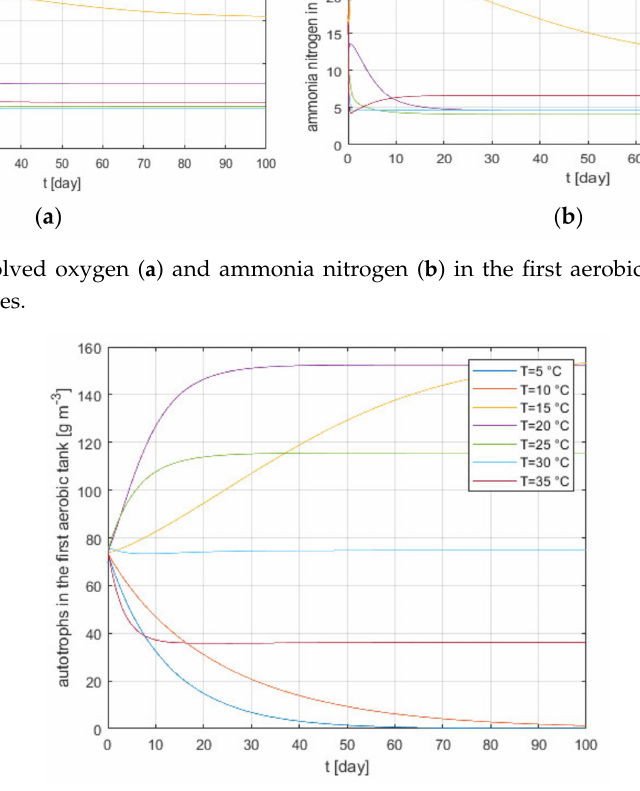
Figure 12. Autotrophs in the first aerobic tank for di ff erent temperature